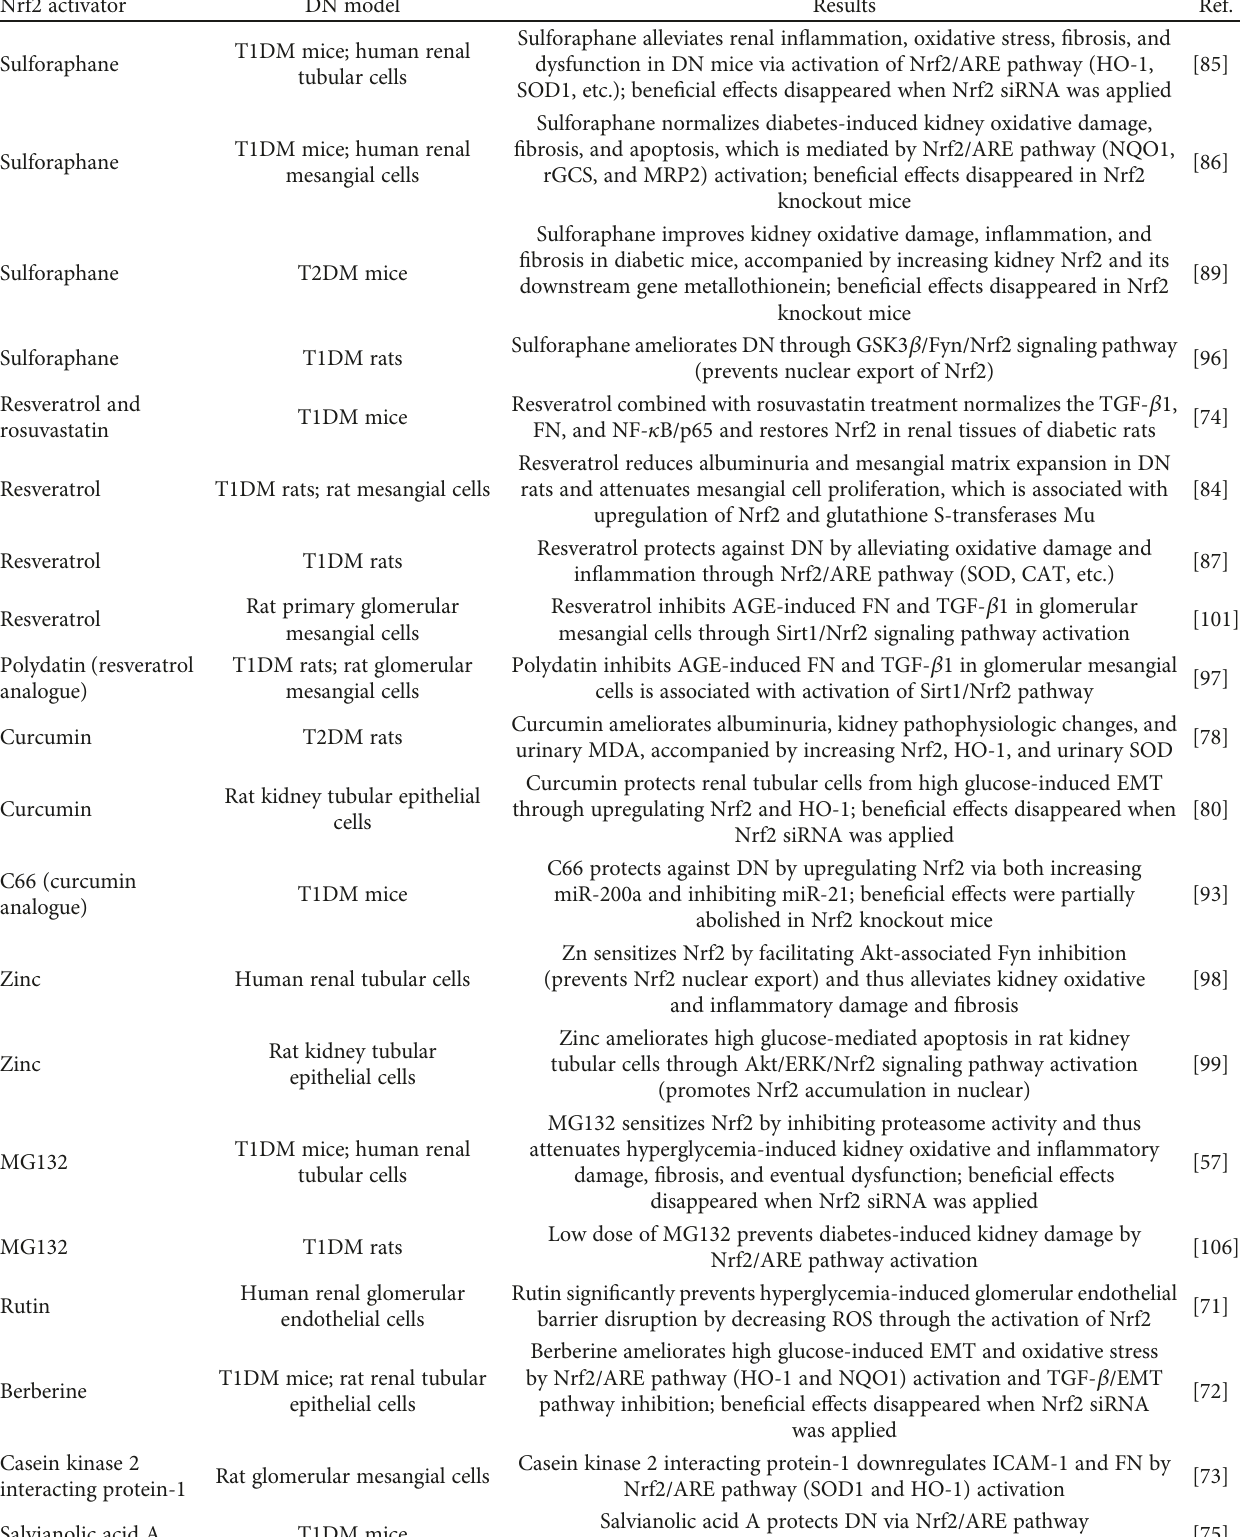
Table 1: Bene fi cial e ff ect of Nrf2 activators on experimental